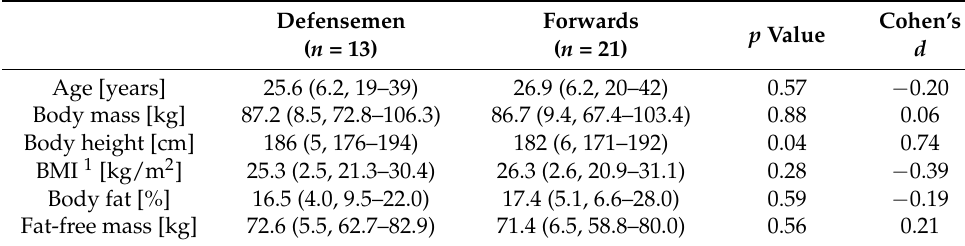
Table 1. Age and anthropometric characteristics of ice hockey players by playing position. Values presented as mean (one standard deviation, minimum and